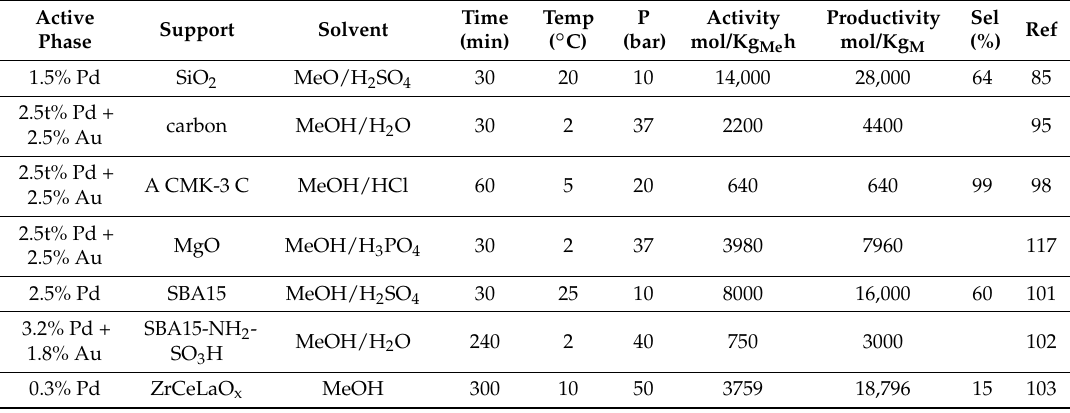
Table 2. The performance of some Pd and Pd/Au catalysts on different